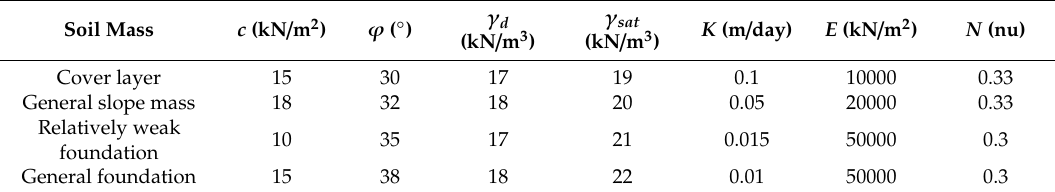
Table 2. Mass properties of each layer.